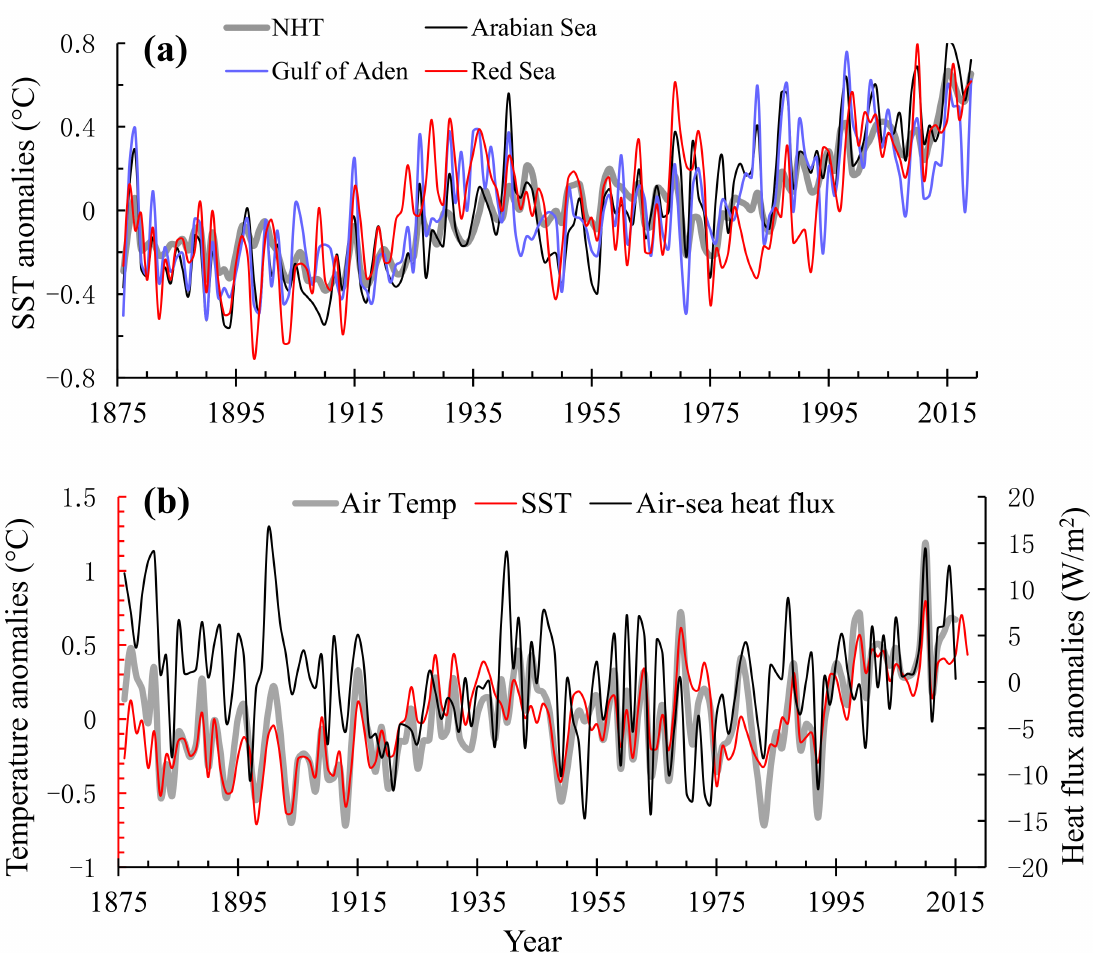
Figure 4. Anomalies of Red Sea SST versus SST anomalies of Gulf of Aden, Arabian Sea, and Northern Hemisphere (NHT) ( a ) and anomalies of surface air temperature and the net air–sea heat flux ( b ). A positive heat flux corresponds to a downward